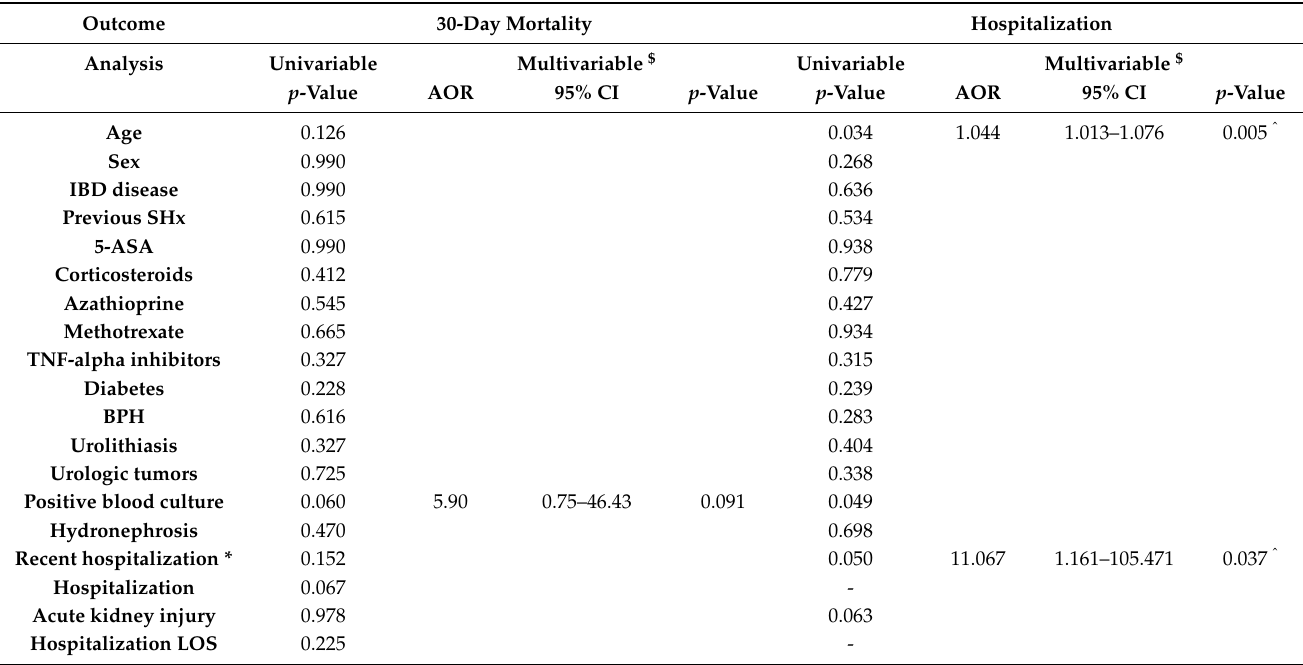
Table 4. Univariable and multivariable analyses: odds ratio and adjusted odds ratio for 30-day mortality and hospitalization among IBD patients treated for urinary tract